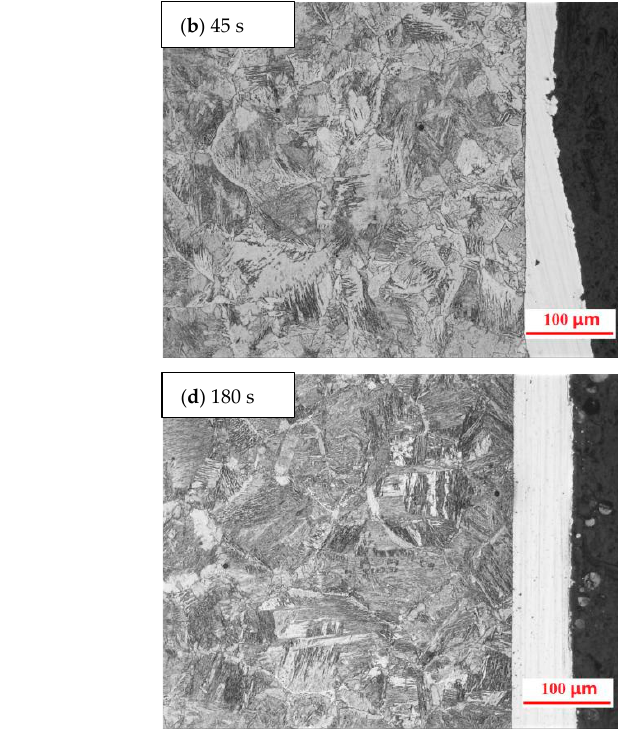
Figure 2. The microstructures of the Cu–steel interface with hot-dipping time of 60 s under different temperatures.